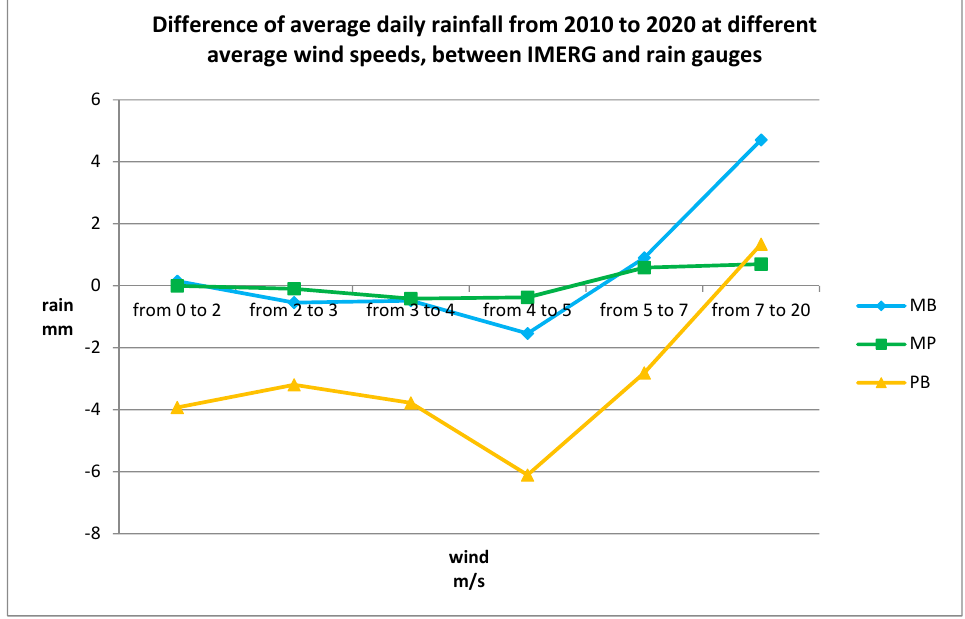
Figure 3. Average daily rainfall from 2010 to 2020 at different average wind speeds (0–2; 2–3; 3–4; 4–5; 5–7; 7–20) for MB (Monte Bove), MP (Monte Prata), PB (Pintura di Bolognola).